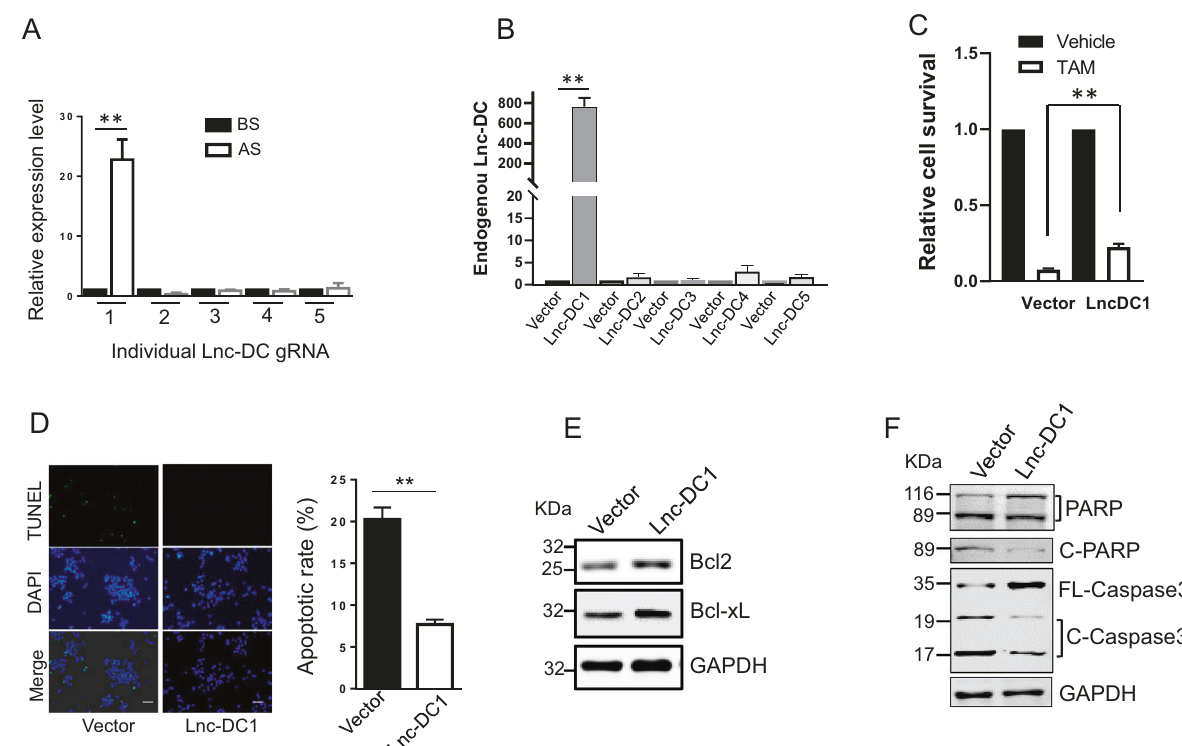
Fig. 2 Lnc-DC promotes tamoxifen resistance. A Lnc-DC gRNA 1 (Lnc-DC1) is only one of 5 gRNAs enriched after estrogen deprivation selection using gRNA speci fi c primers. B Lnc-DC1 causes upregulation of the endogenous Lnc-DC. Each of 5 Lnc-DC gRNAs was individually introduced into MCF-7 SAM cells and their expression was determined by qRT-PCR using Lnc-DC speci fi c primers Lnc-DC-RT-5.1 and Lnc-DC- RT-3.1. C Lnc-DC1 expressing cells are more resistant to tamoxifen (TAM). The cells infected with vector or Lnc-DC1 expression lentivirus were treated with 10 μ M tamoxifen for 3 days before relative cell survival was determined by MTT assay. D Suppression of tamoxifen-induced apoptosis in Lnc-DC1 expressing cells, as determined by TUNEL assay. E Upregulation of Bcl2 and Bcl-xL in Lnc-DC1 expressing cells, as detected by Western blot. F Lnc-DC suppresses the cleavage of PARP and Caspas3. Values are mean ± SD ( n = 3). ** p < 0.01; bar, 10